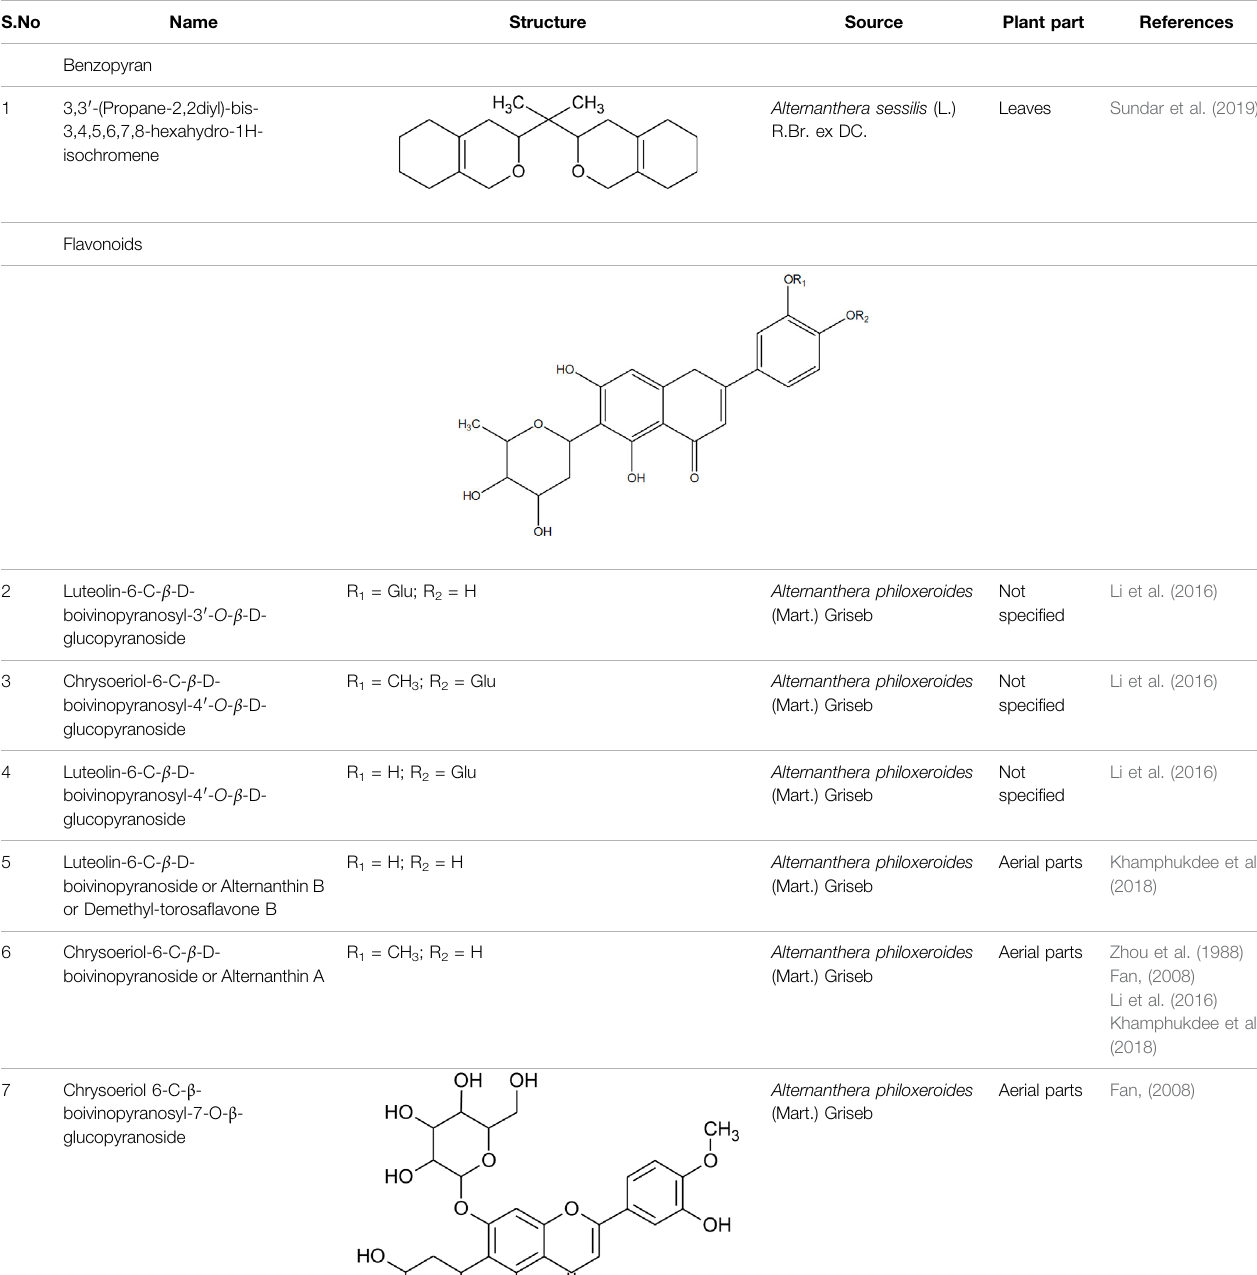
TABLE 1 | Chemical constituents isolated from genus Alternanthera